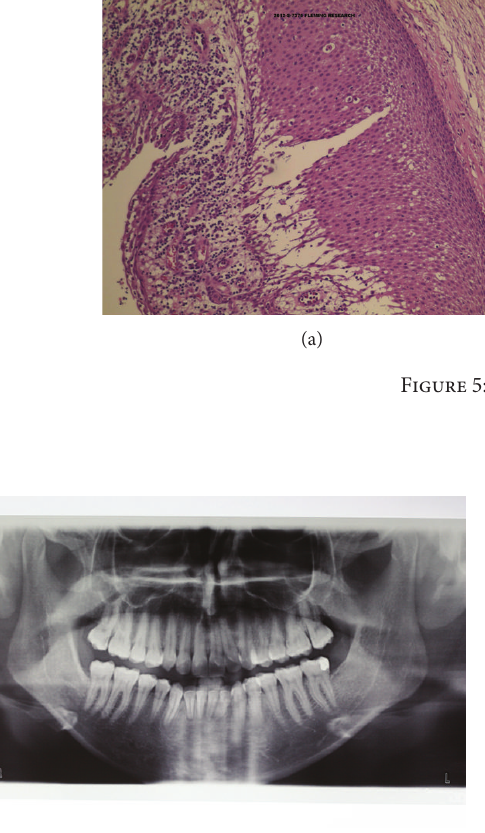
Figure 6: Orthopantomography at 1